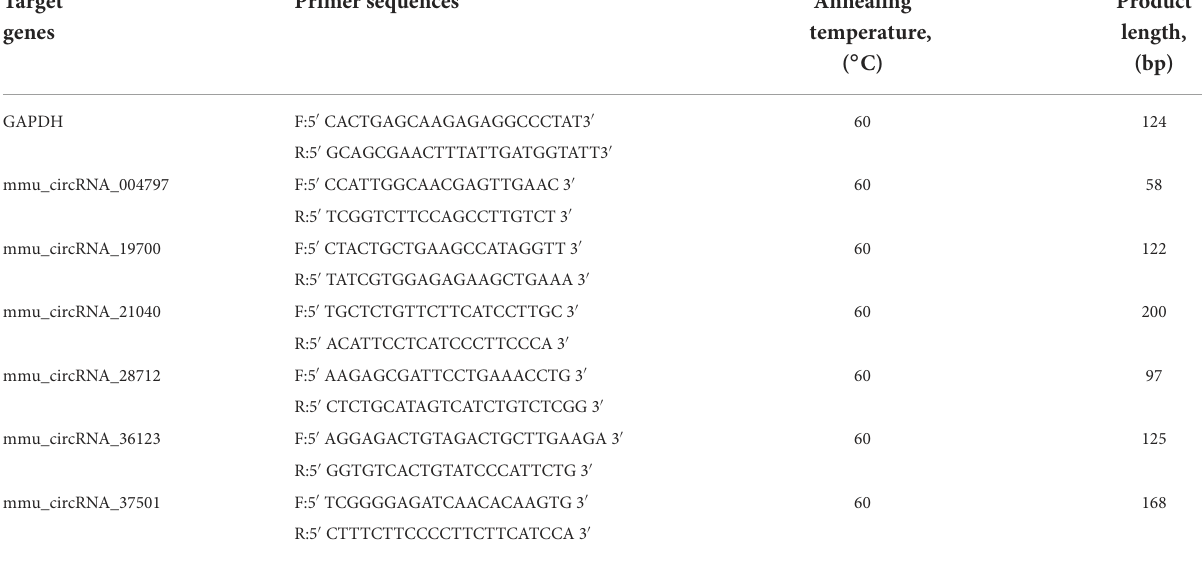
TABLE 1 Quantitative real-time PCR primers used to confirm the expression of circRNAs. Target